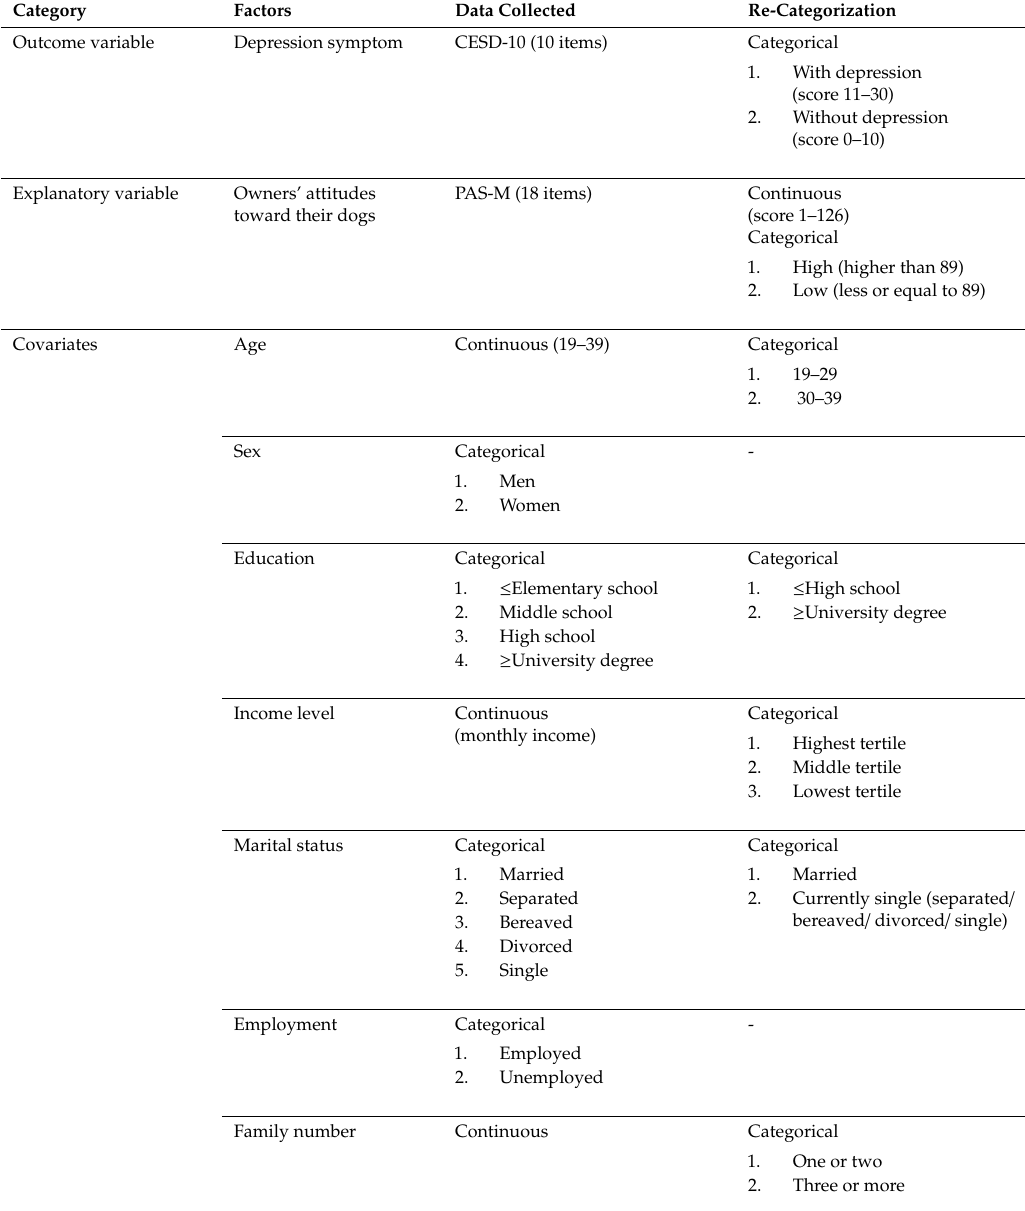
Table 1. Variables used in this study and their